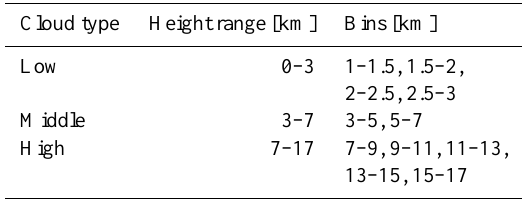
Table 2. Description of the height grid for calculation and analysis of CTH time